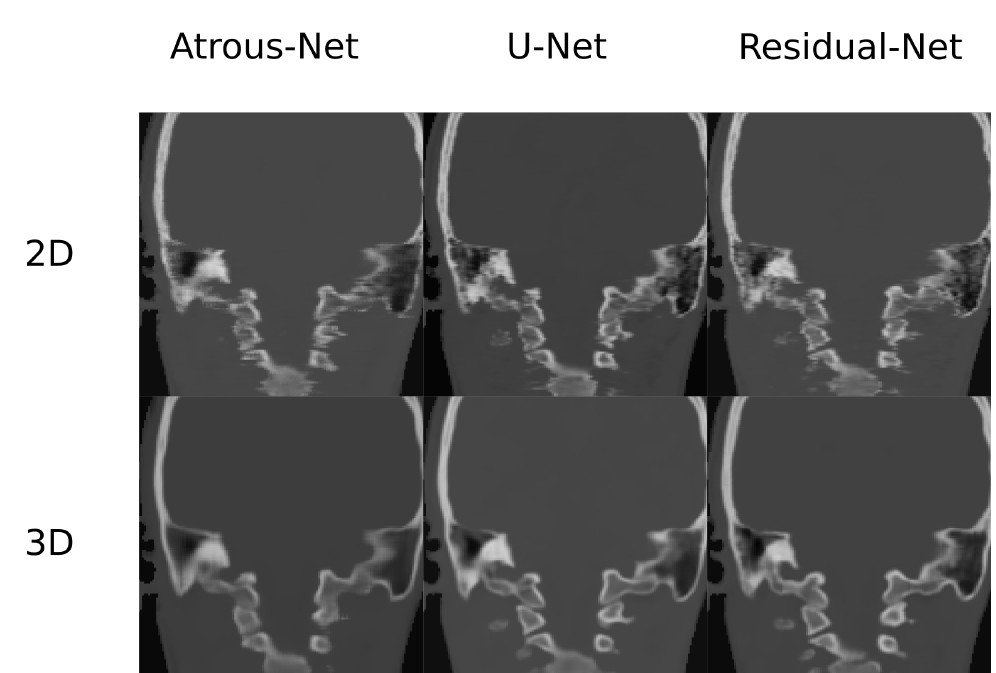
Figure 12. Comparison in the sagittal and coronal direction for the head between the 2D and 3D schemes.